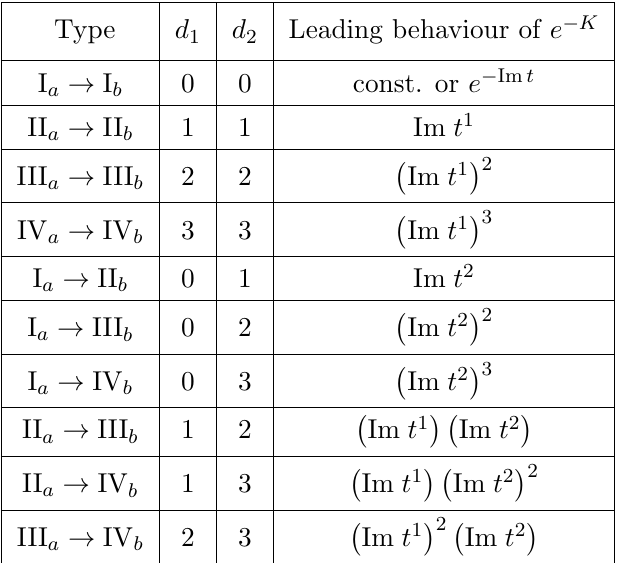
Table 4 . Leading growth terms of e (cid:0) K when approaching the singular locus t 1 = t 2 = i 1 obtained by using (2.77) and